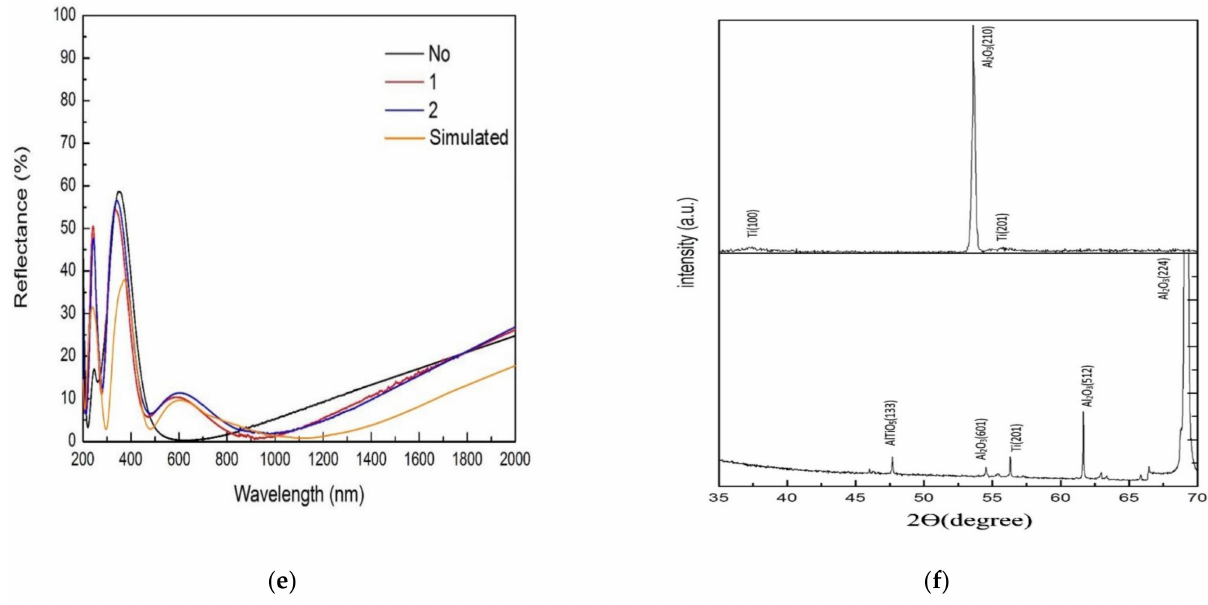
Figure 4. ( a ) SEM top-view image, ( b ) AFM image and ( c ) SEM cross-sectional image of the Al 2 O 3 /Ti/Al 2 O 3 CSSA before annealing, and( d ) SEM top-view image after annealing. ( e ) Opti- cal properties, respectively, before and after annealing 1 and 3 times for 16 h at 550 ◦ C and one simulated optical reflectance. ( f ) X-ray diffraction patterns of the multilayer stack before and after annealing 3 times for 16 h at 550 ◦